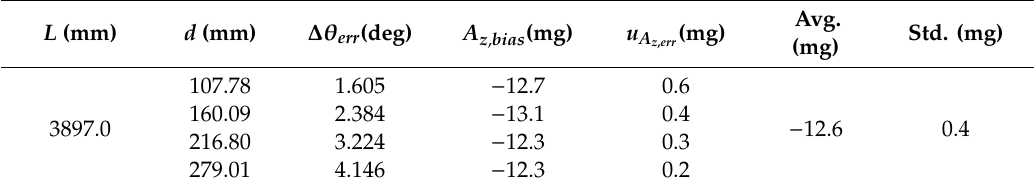
Table 7. The parameters d , L , and A z , of f of the calibration experiments.